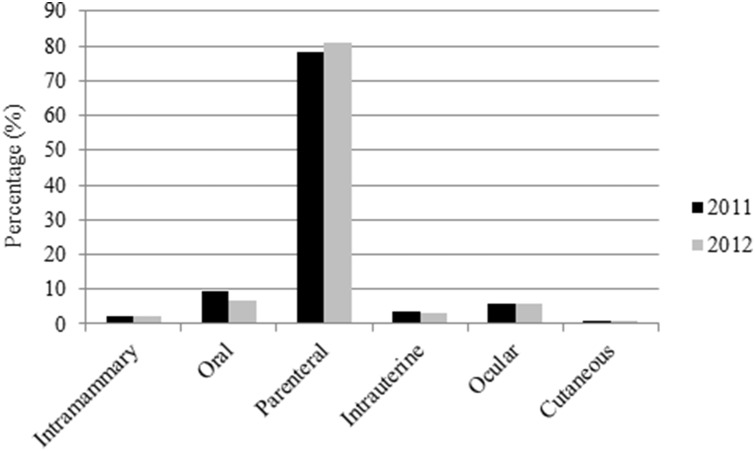
The application methods of antibiotics for small ruminants in 2011 and 2012 in the Netherlands.